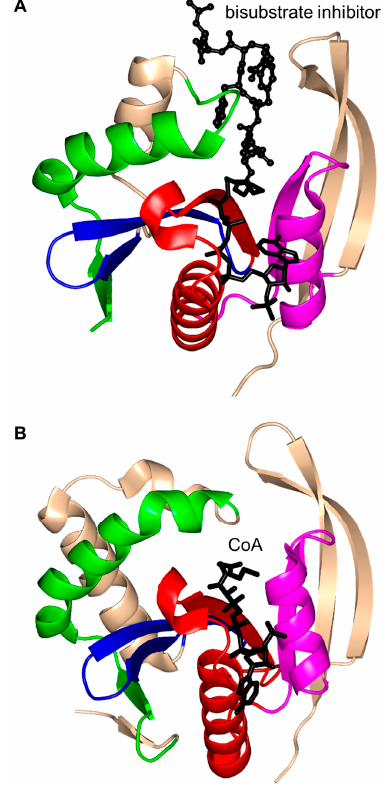
Figure 15. Cartoon representation of the structures of ribosomal protein N α - acetyltransferases. ( A ). Salmonella typhimurium RimI in complex with a bisubstrate inhibitor, C-term-Arg-Arg-Phe-Tyr-Arg-Ala-N- α -AcCoA (PDB ID: 2CNM [147]); and ( B ) RimL from S. typhimurium in complex with CoA (PDB ID: 1S7N [108]). The conserved and non-conserved motifs of the GNAT domains are colored as in Figure 3.